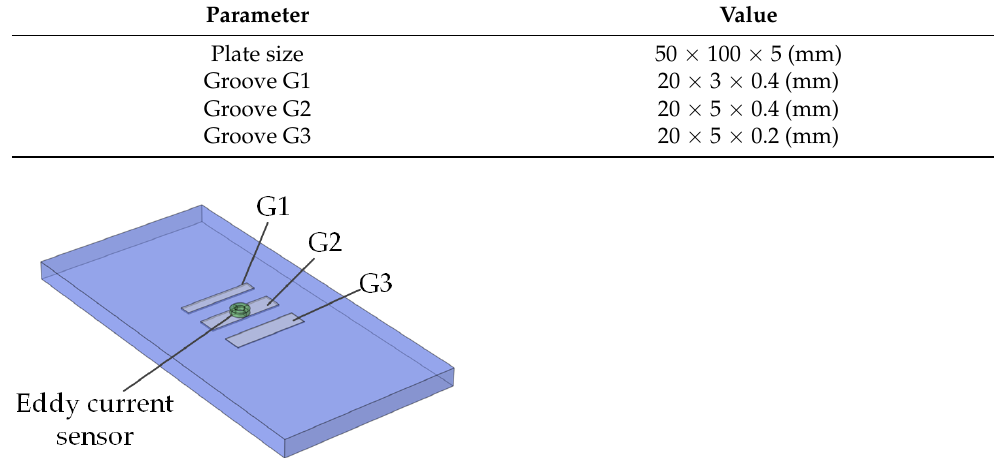
Figure 3. The 3D finite element model.